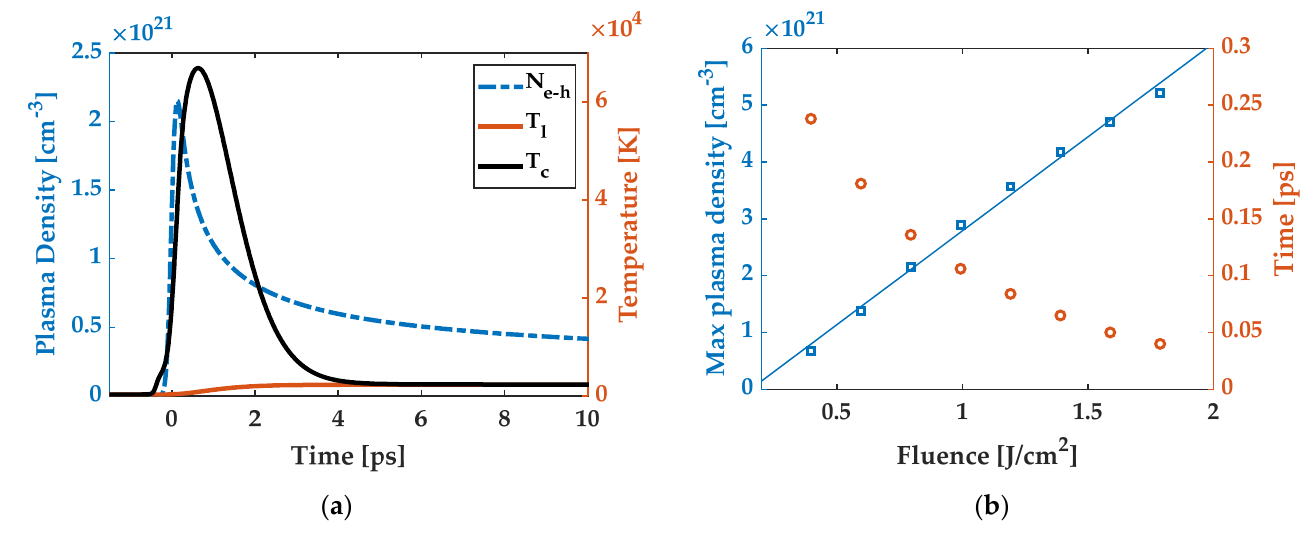
Figure 6. ( a ) Predicted plasma density, electron temperature, and lattice temperature with respective maxima of 2.2 × 10 21 /cm 3 , 6.7 × 10 4 K, and 2274 K for a TTM simulation at the laser fluence of 0.8 J/cm 2 . ( b ) Maximum plasma density and time for reaching corresponding max plasma density as a function of excitation fluence (taken from TTM simulation).